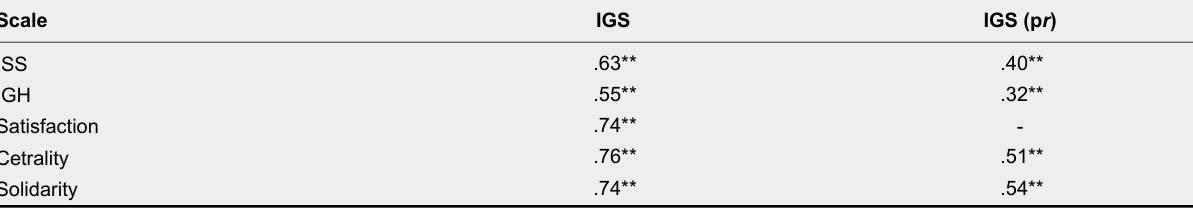
IGS (p r )IGSScale